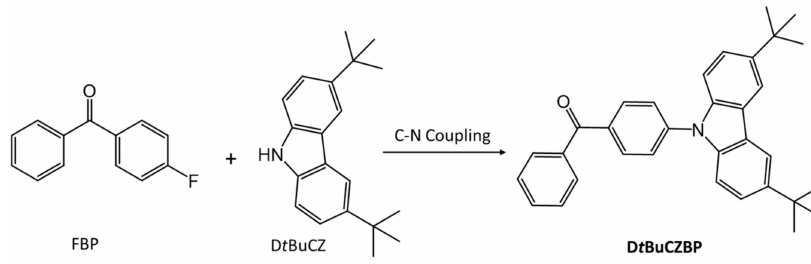
Figure 18. Synopsis of the synthetic route to